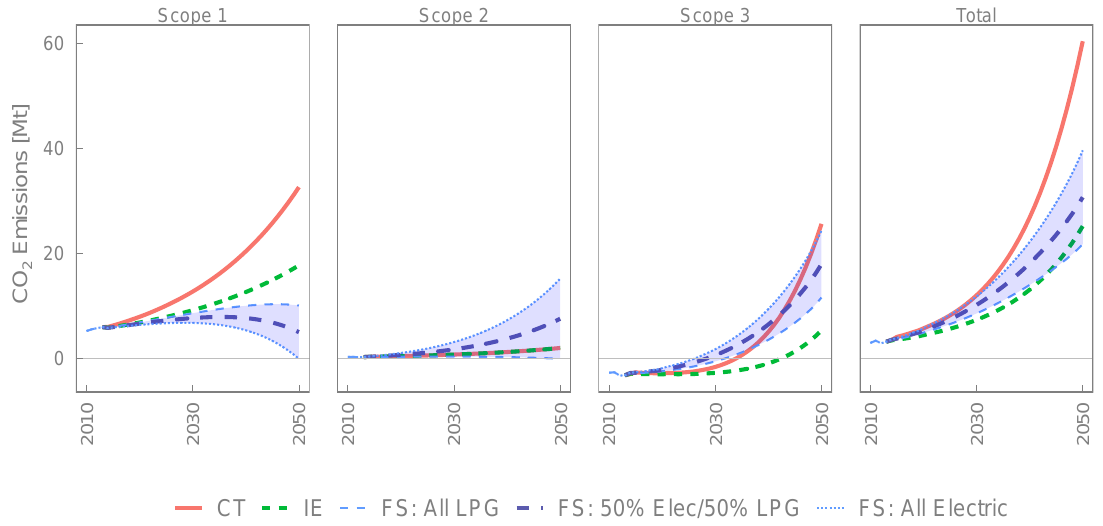
Figure 11. Scope 1, 2, 3, and Total emissions for three Scenarios of PSB Consumption in the Honduran Residential Cooking Sector. The shaded region represents the range of emissions for Fuel Switching between all electric and all